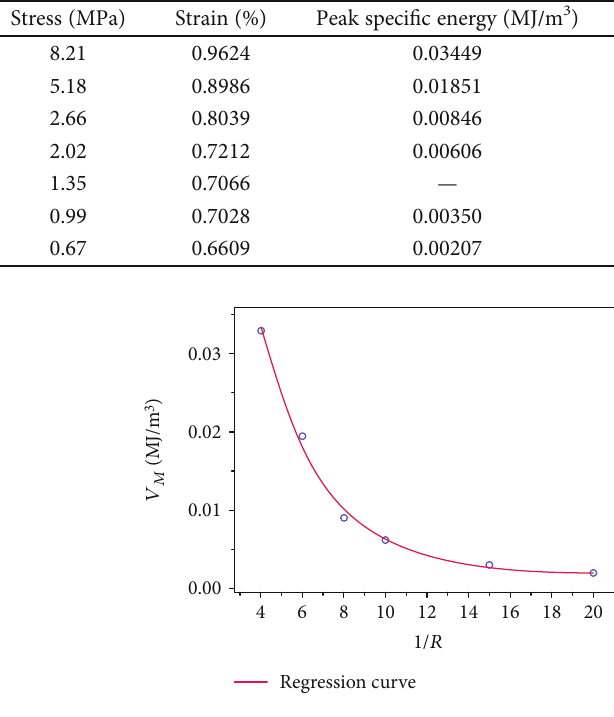
Figure 5: Representative stress-strain curve.